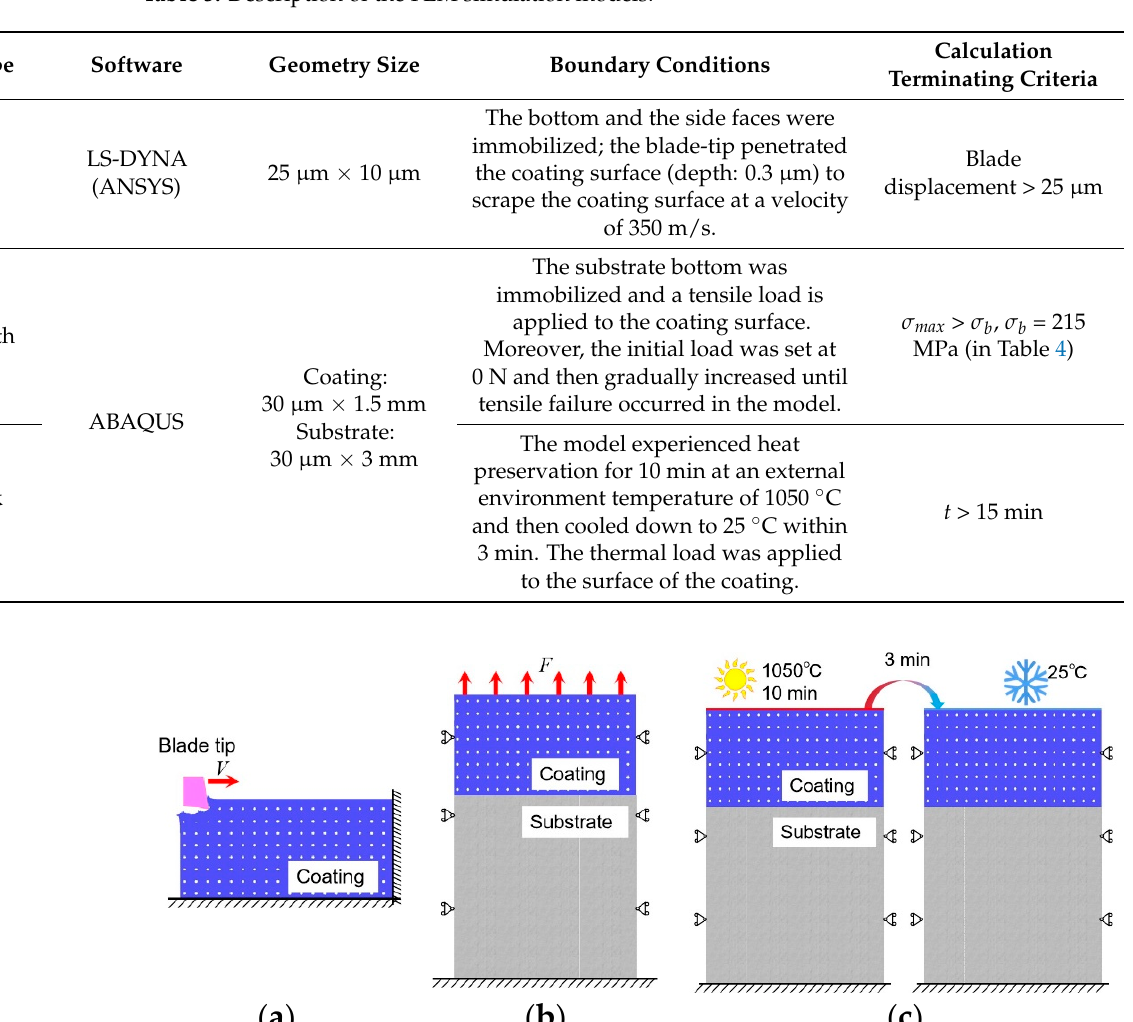
Table 3. Description of the FEM simulation models.